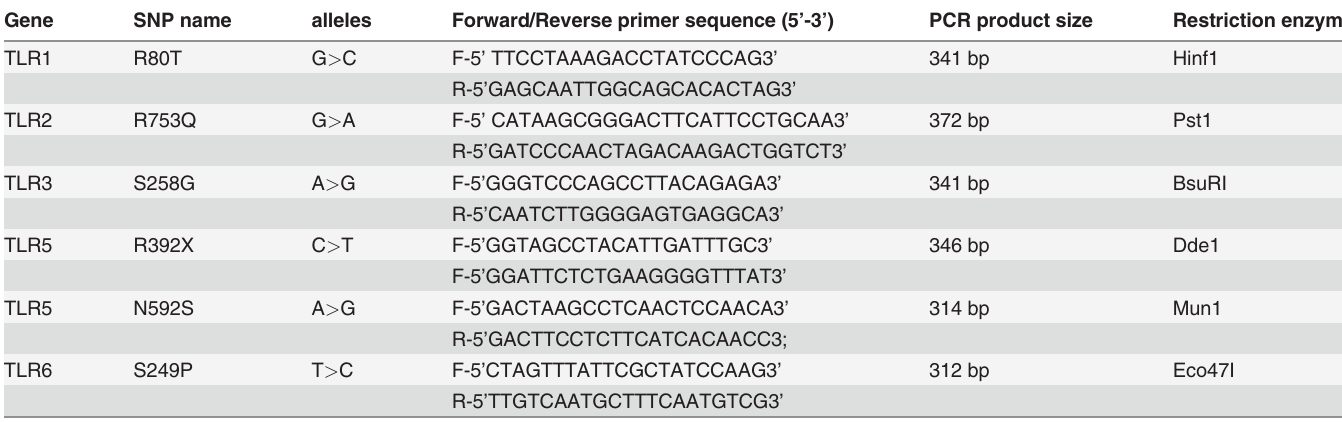
Table 2. Detail of PCR primers used for Restriction fragment length polymorphism. Gene SNP